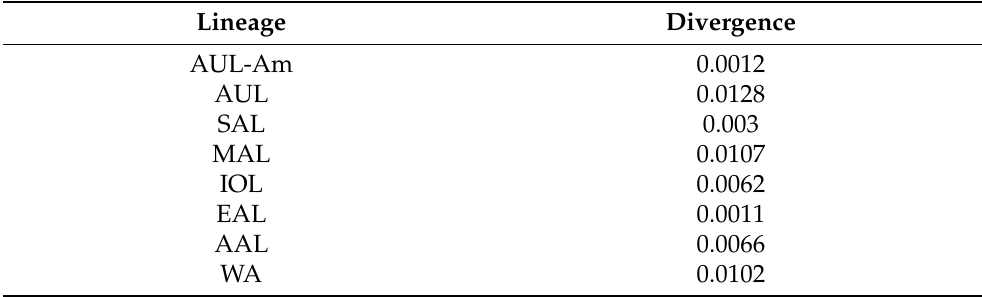
Table A1. Estimates of average evolutionary divergence over sequence pairs within Chikungunya virus lineages. The number of base substitutions per site from averaging over all sequence pairs within each group are